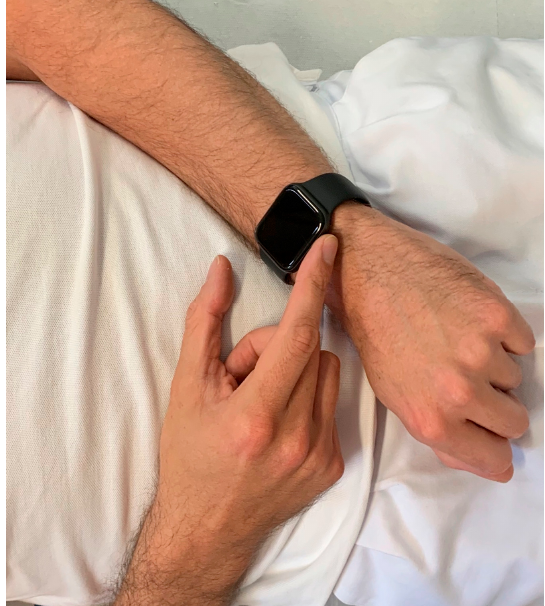
Figure 1. Registration of Einthoven lead I between the left arm wrist and the right index finger.